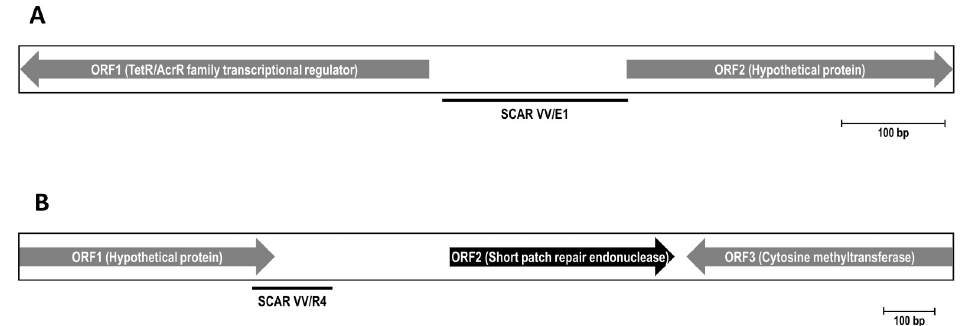
Fig 3. Representative maps of the characterized RAPD fragments. (A) Streptomyces sp. VV/E1 and (B) Streptomyces sp. VV/R4. Incomplete ORFs are indicated by grey arrows, whereas black arrows correspond to complete ORFs. The relative positions of the amplified SCAR markers developed are indicated by a black line. GeneBank accession numbers: MH048872 ( Streptomyces sp. VV/E1) and MH048873 ( Streptomyces sp. VV/R4).